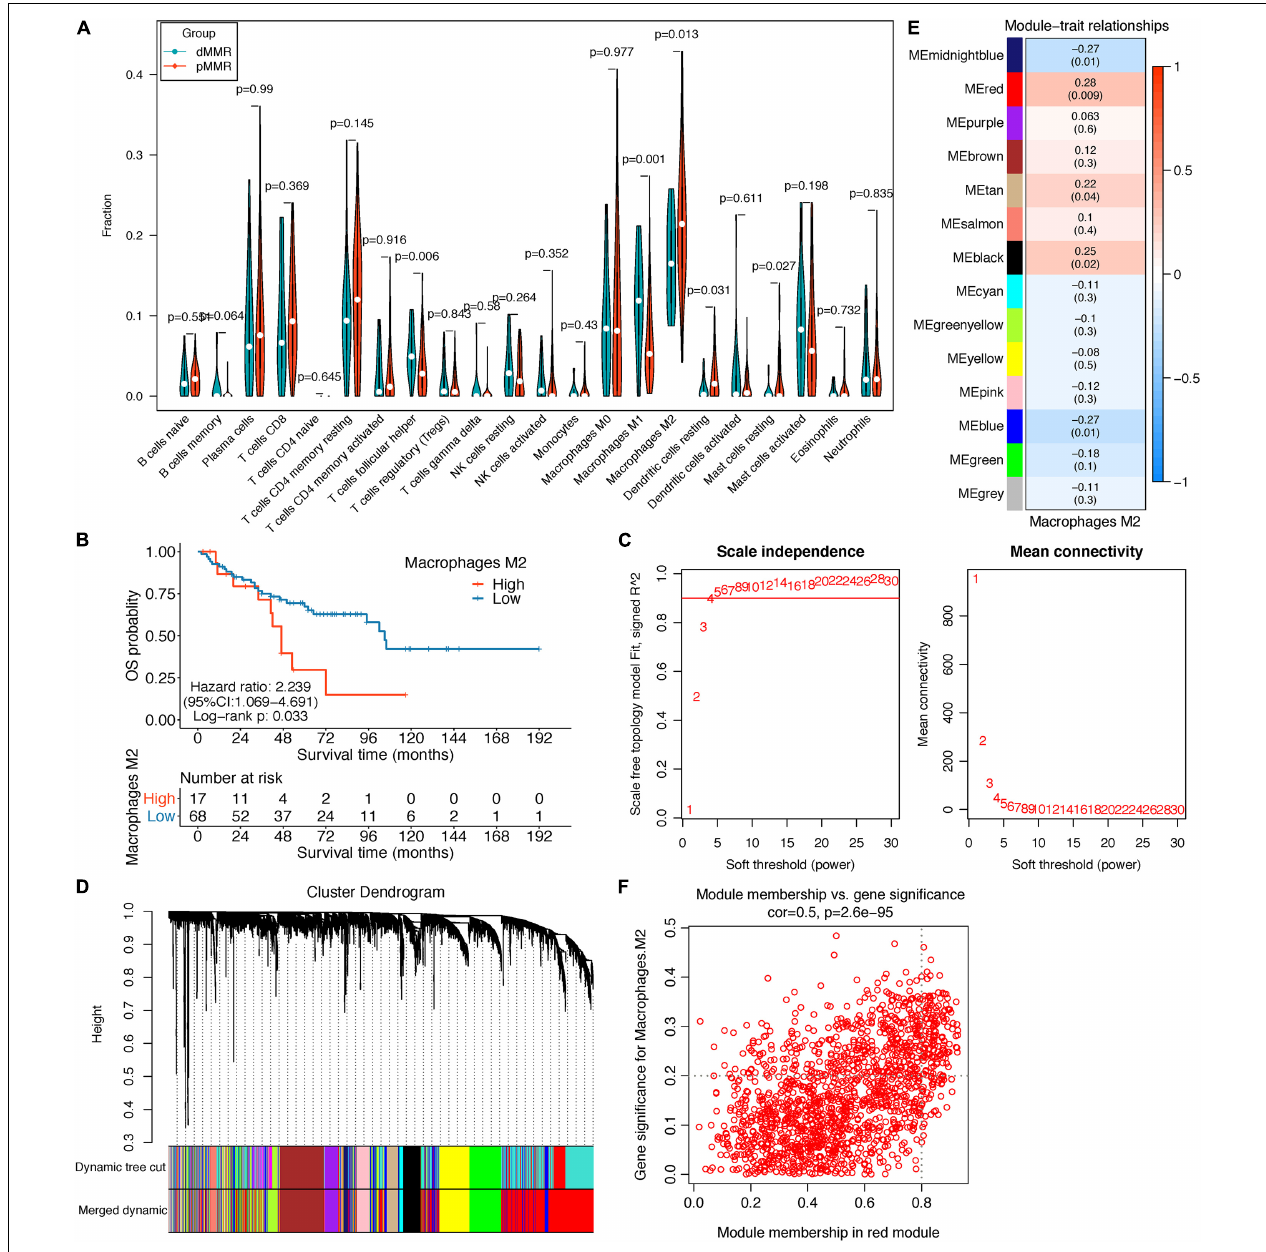
FIGURE 2 | (A) Violin plot displayed the CIBERSORT TIIC fraction difference between pMMR (85) and dMMR (20) stage III/IV CRC samples; only samples with a CIBERSORT P -value < 0.05 were screened for this analysis. (B) Survival curve of the high- and low-M2 macrophage groups in stage III/IV pMMR CRC patients. (C–F) Co-expression network analysis by WGCNA. (C) Analysis of network topology for optimal soft-threshold power. (D) Dendrogram of genes clustered with dissimilarity based on topological overlap; each color below represented an expression module of highly interconnected groups of genes in the constructed gene co-expression network. Gray indicated that genes were not incorporated into any module. (E) Heatmap of the correlation between each module’s module eigengene and M2 macrophage fractions; each cell contains the Pearson’s correlation coefficient and the corresponding P -value. The red module was the most significant module with the strongest correlation. (F) Scatterplot of gene significance (GS) for M2 macrophage fractions vs. module membership (MM) in the red modules. TIICs, tumor-infiltrating immune cells; pMMR, mismatch-repair-proficient; dMMR, mismatch-repair-deficient; CRC, colorectal cancer; WGCNA, weighted gene co-expression network